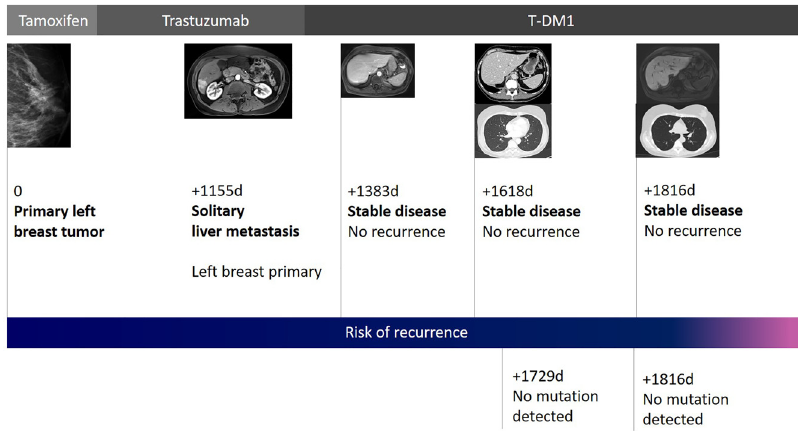
Figure 4: Liquid profiling laboratory developed test (LDT) for personalized follow-up: TP53